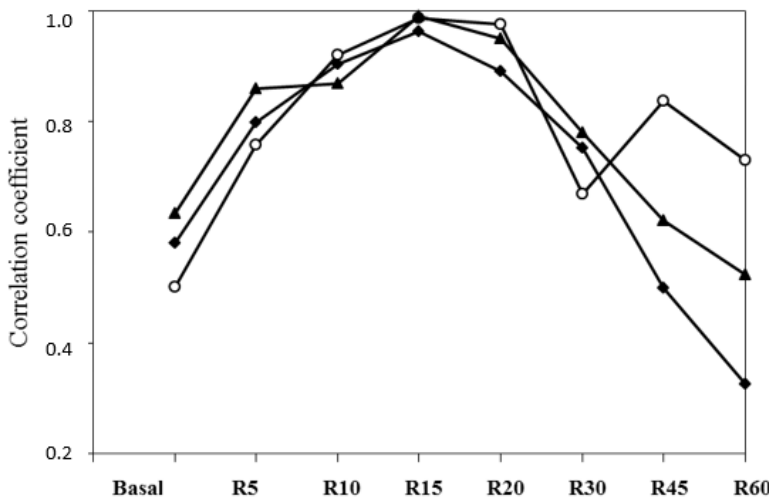
Figure 6. Correlations between the plasma area under the concentration curves (AUC) from time 0 to 60 min and basal plasma FFA or plasma FFA responses (R) at different times after the isoproterenol challenge in control (-o-), underfed (black-filled triangle) or overfed (fat, black-filled diamond) Merinos d’Arles meat ewes.